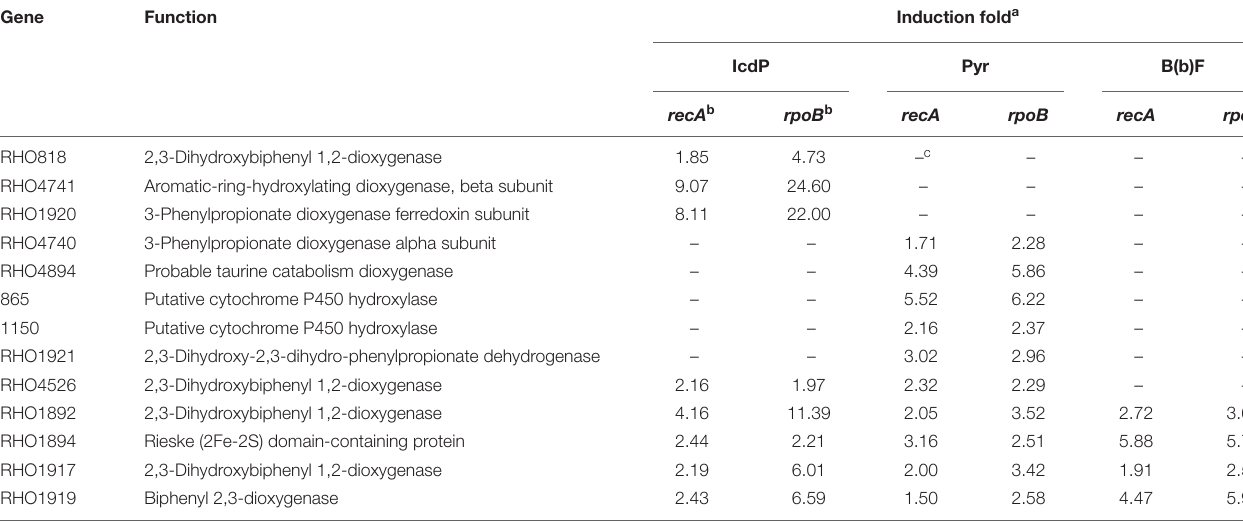
TABLE 3 | Different expressed fold of RHOs and CYPs on IcdP, PYR, and BbF as the sole carbon source in strain IcdP1. Gene